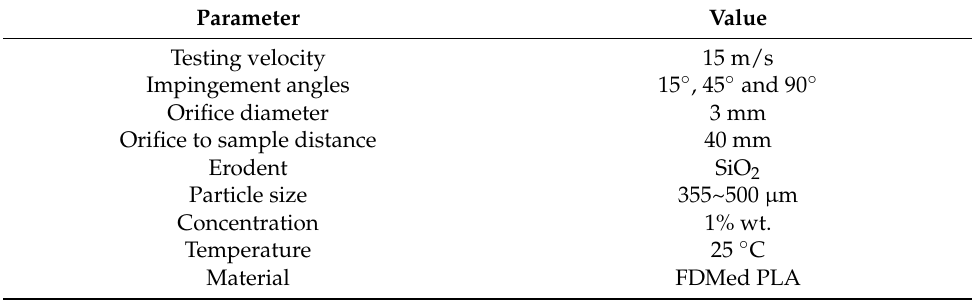
Table 3. Testing conditions for slurry impact of FDM-processed PLA.